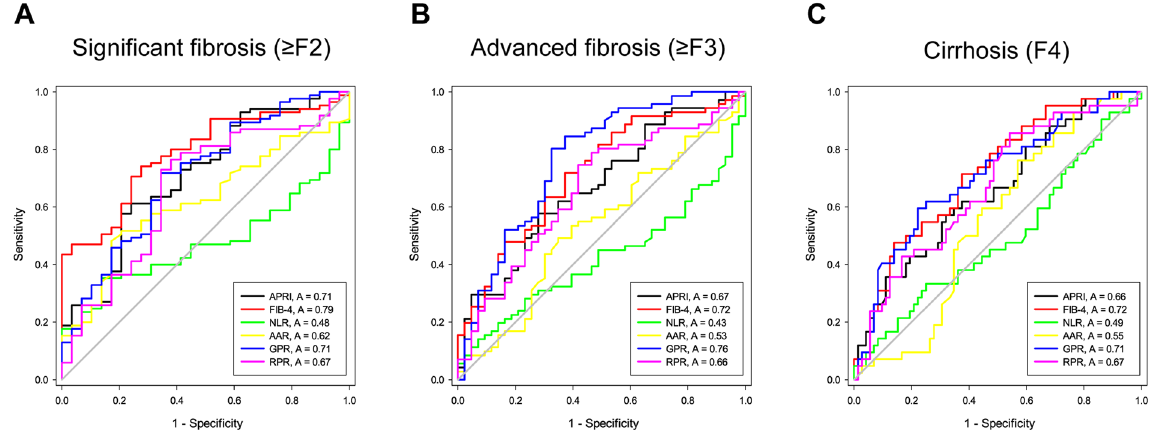
Figure 4. Receiver operating characteristic (ROC) curves of APRI, FIB-4, NLR, AAR, RPR and GPR in the prediction of significant liver fibrosis ( A ), advanced liver fibrosis ( B ) and liver cirrhosis ( C ) in HBeAg negative